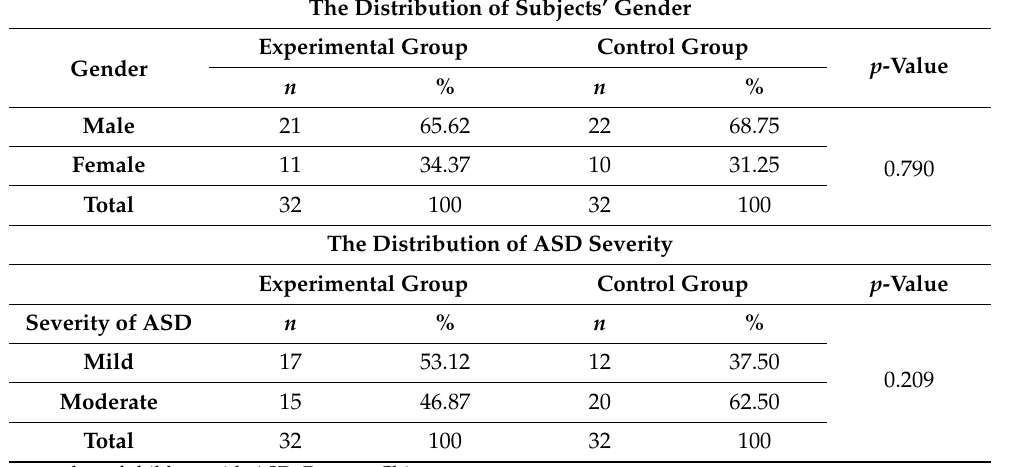
Table 1. The Distribution of Subjects’ Gender. The Distribution of Subjects’ Gender